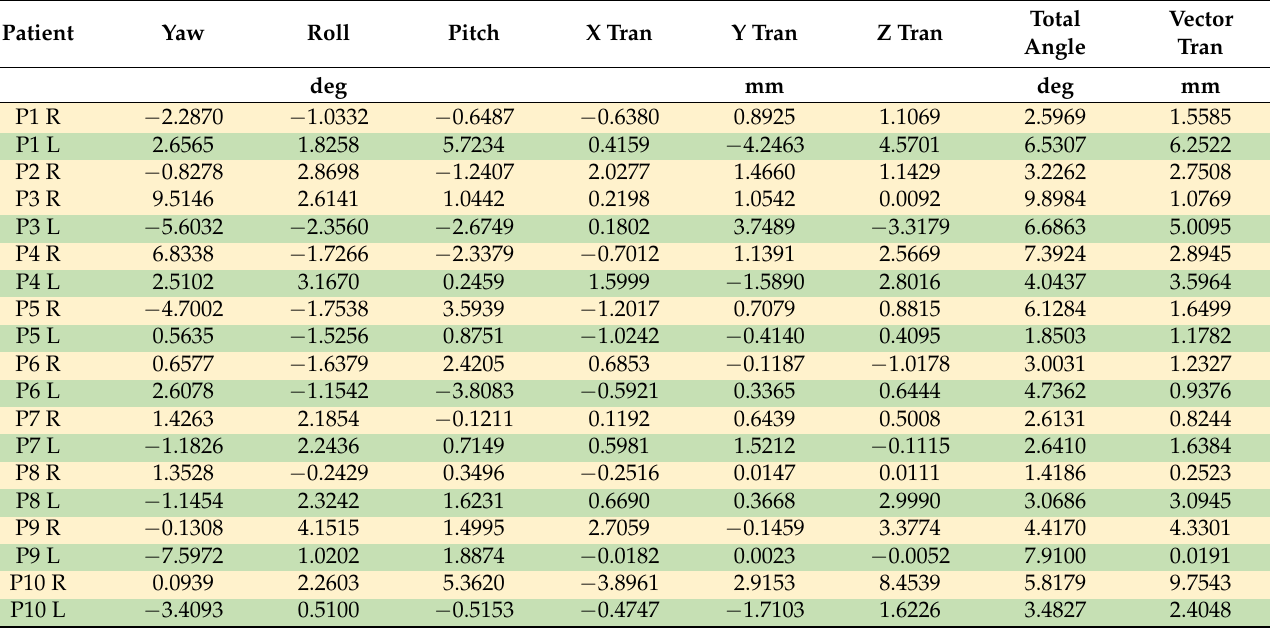
Table 2. Values obtained for each patient from the analysis of the CMS roto-translation process. Right-side segments are highlighted in green, left-side segments in